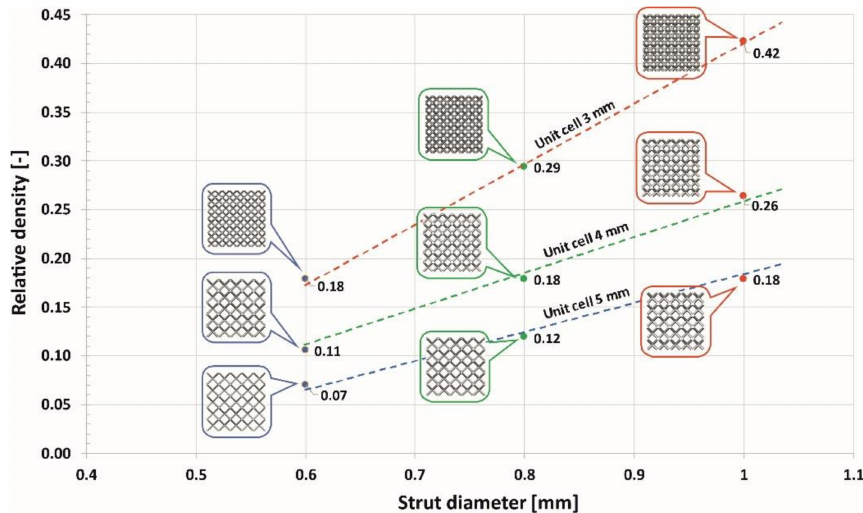
Figure 3. Map of the relationship between the value of the structure relative density and the adopted geometrical